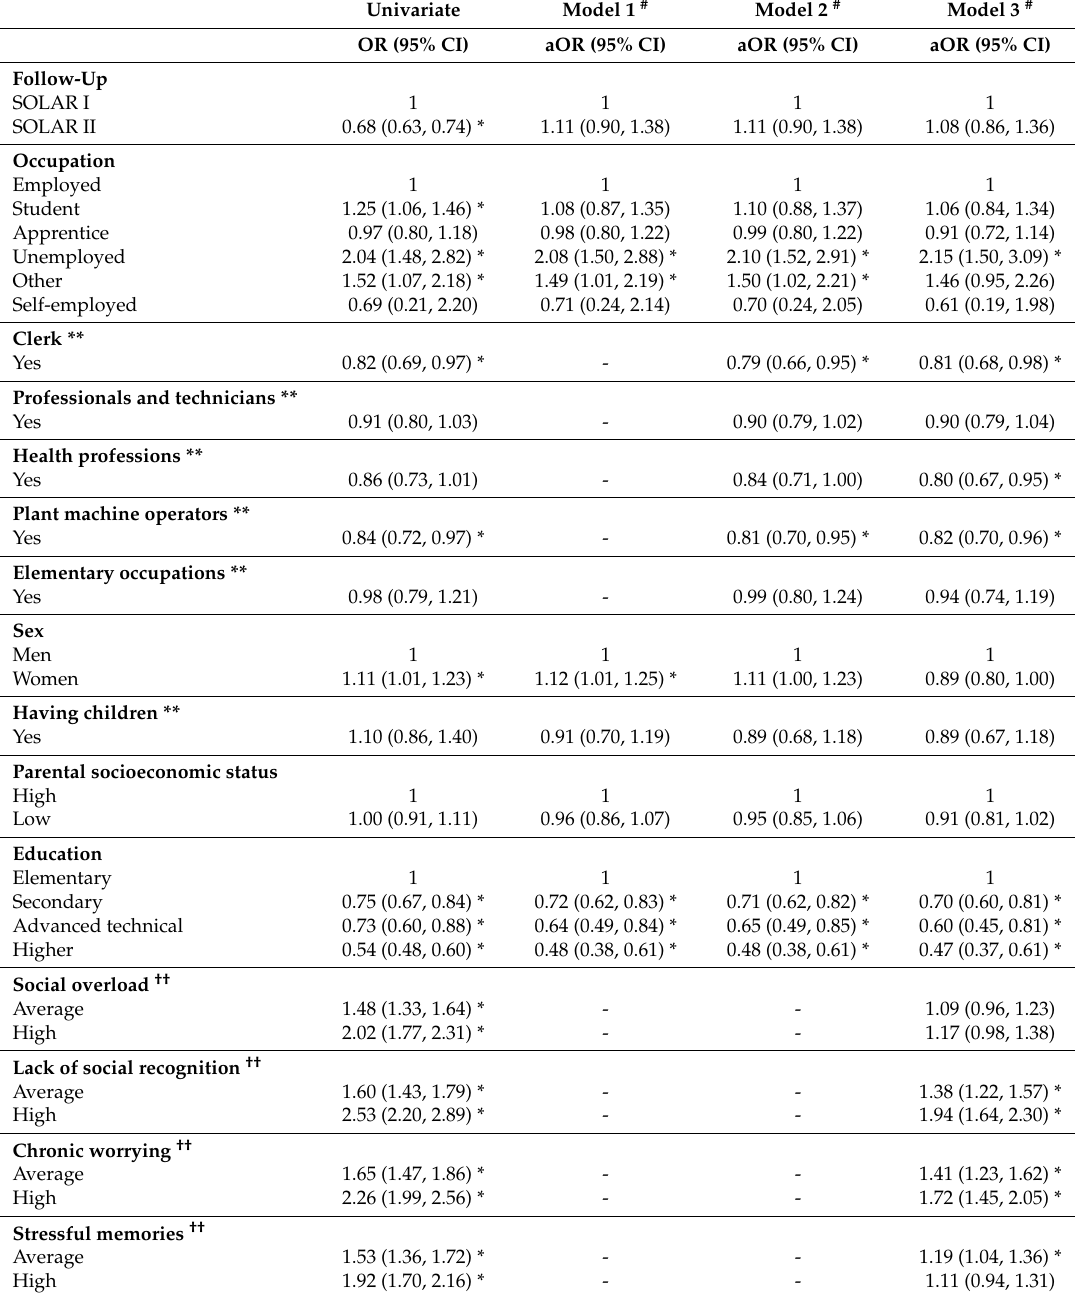
Table 3. Unadjusted (OR) and adjusted odds ratios (aOR) after multiple imputation with 95% confidence intervals (95% CI) for work discontent using ordinal GEE models in a prospective cohort of 1688 young adults in